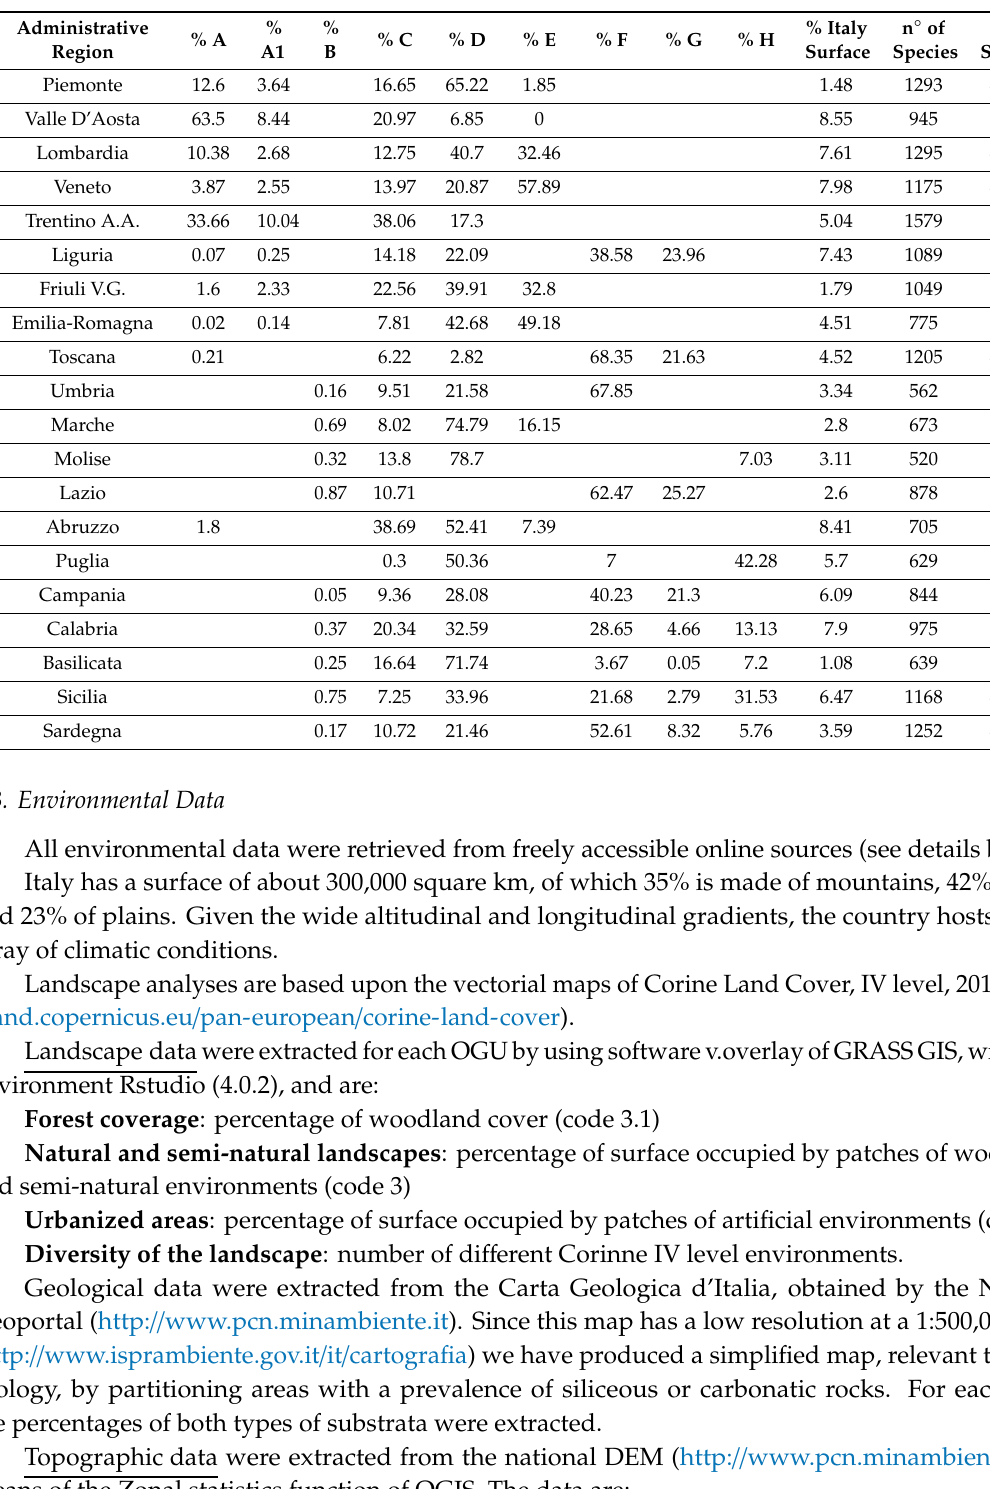
Table 2. Number of ecoregions for each Administrative region in Italy, and percentages of their surface areas in each region. The ecoregions are: Alpine (A), Subalpine (A1), Oromediterranean (B), Montane (C), Dry Submediterranean (D), Padanian (E), Humid Submediterranean (F), Humid Mediterranean (G), Dry Mediterranean